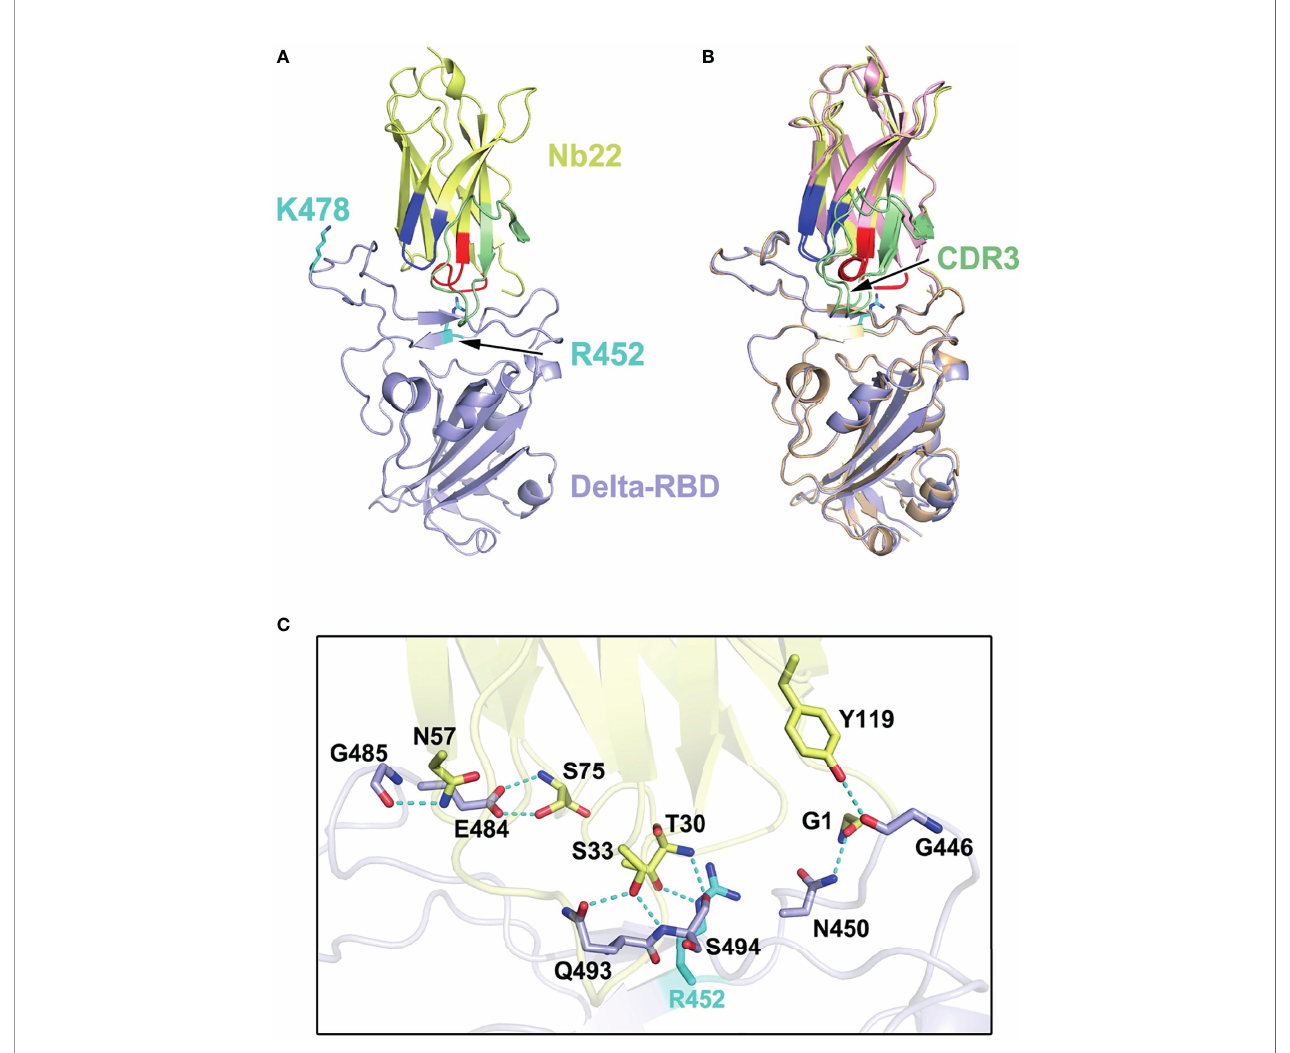
FIGURE 4 | Structural analysis of Nb22 and Delta RBD complex. (A) The two mutation sites of Delta RBD. K478 is located outside the CDR binding regions, R452 is on the CDR2 recognized epitope. R452 and K478 are colored in cyan, and the epitope of CDRs is colored identical to Figure 3 . (B) The superimposition of WH01 RBD-Nb22 (orange and pink) and Delta RBD-Nb22 (light blue and yellow). (C) The hydrogen bonds on the interaction interface of Delta RBD-Nb22. R452 and Q493 form two additional hydrogen bonds with T30 and S33 of Nb22 The residues identi fi ed are shown in